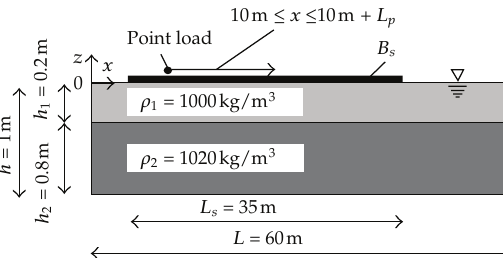
Figure 7: Two-layer system with a floating thin plate, where h 1 (cid:7) 0.2m and h 2 (cid:7) 0.8m. The thin plate, whose length L s is equal to 35.0m, covers the water surface from x (cid:7) 5.0m to 40.0m. The point load moves on a one-way path between x (cid:7) 10.0m and (cid:2) 10.0m (cid:8) L p (cid:3) at a constant velocity.